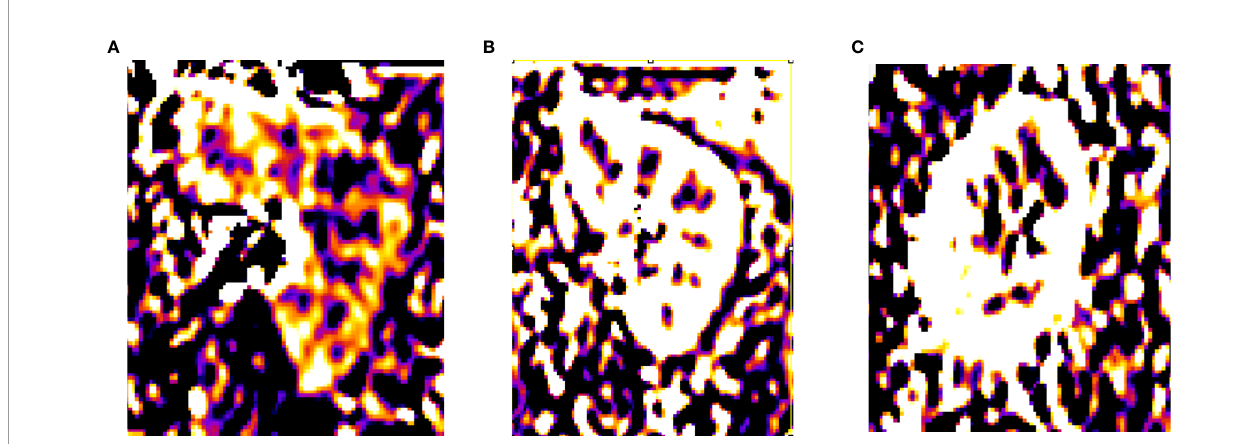
FIGURE 1 | RBF of volunteers. (A) PLD = 500 ms, (B) PLD = 1,000 ms, (C) PLD = 2,000